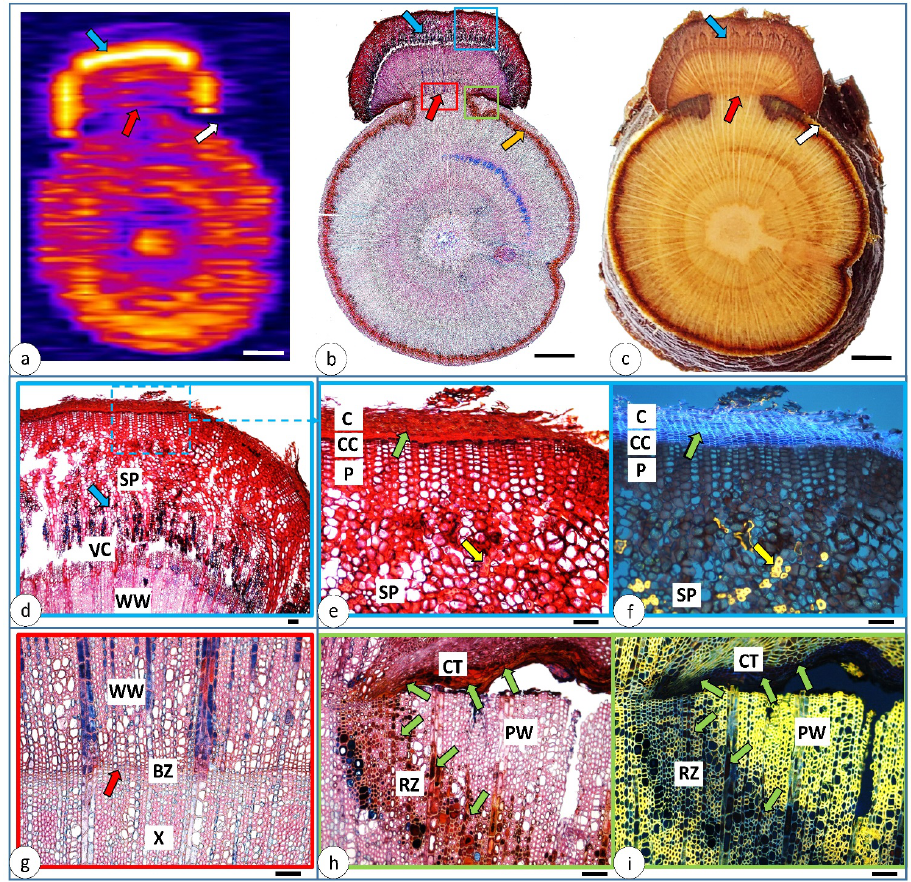
Figure 6. Cherry laurel ( Prunus laurocerasus ); sample PrLa 151 – stem cross section (located at the red dashed line in Figure 3 i). ( a ) the MRI cross-section; ( b ) cross-section of the in bright field; ( c ) macro image of cross section; ( d ) wound wood (WW), vascular cambium (VC), secondary phloem (SP) and periderm; ( e and f ) bright-field periderm and UV fluorescence, detail of secondary phloem (SP) with lignified sclereids, phelloderm (P), cork cambium (CC) and cork (C) that is suberized; ( g ) secondary xylem before injury (X), barrier zone (BZ) and xylem after injury—wounded wood (WW); ( h and i ) callus tissue (CT), reaction zone (RZ) and exposed dehydrated tissue i.e. protection wood (PW) in bright field and UV fluorescence. ROIs are marked by colour frames of the figures. Scale bars: a, b and c = 2 mm; d, e, f, g, h and i = 100 µm.